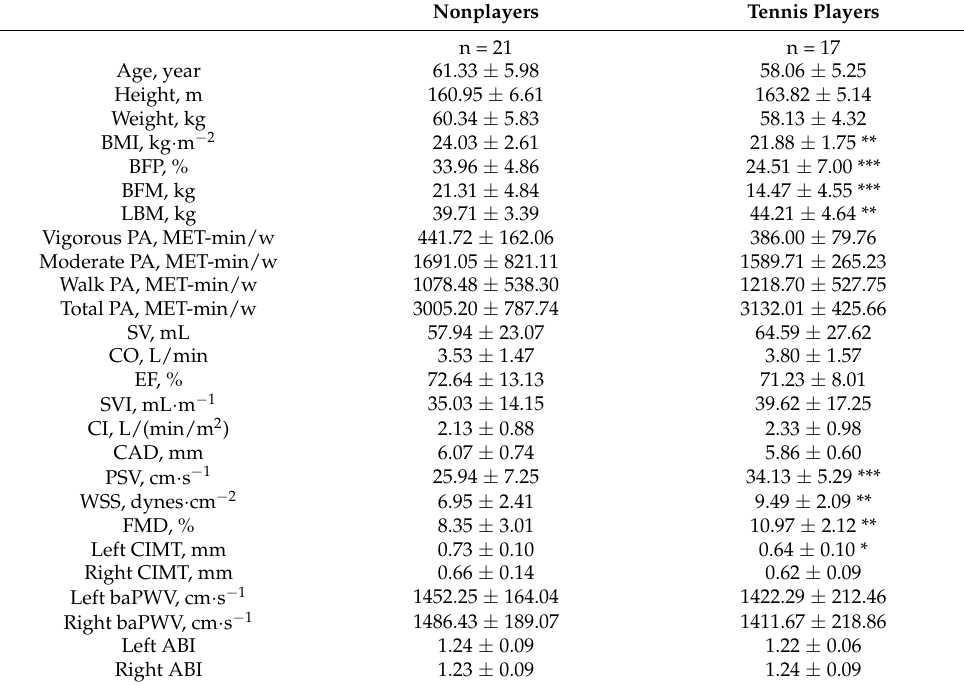
Table 1. Comparison of characteristics between the tennis players and the nonplayers.